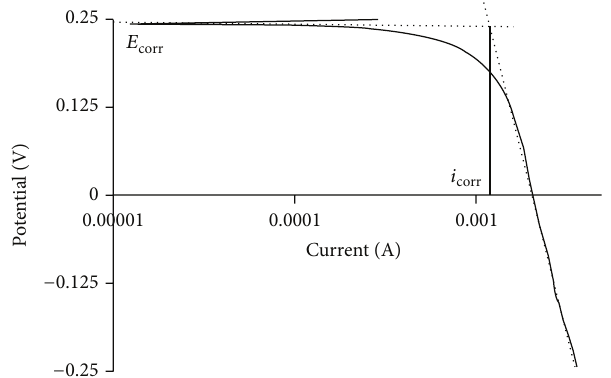
Figure 2: The simplified system of 𝑖 corr extraction. The linear part of the cathodic region is extended until it reaches the 𝐸 corr potential to determine 𝑖 corr value.